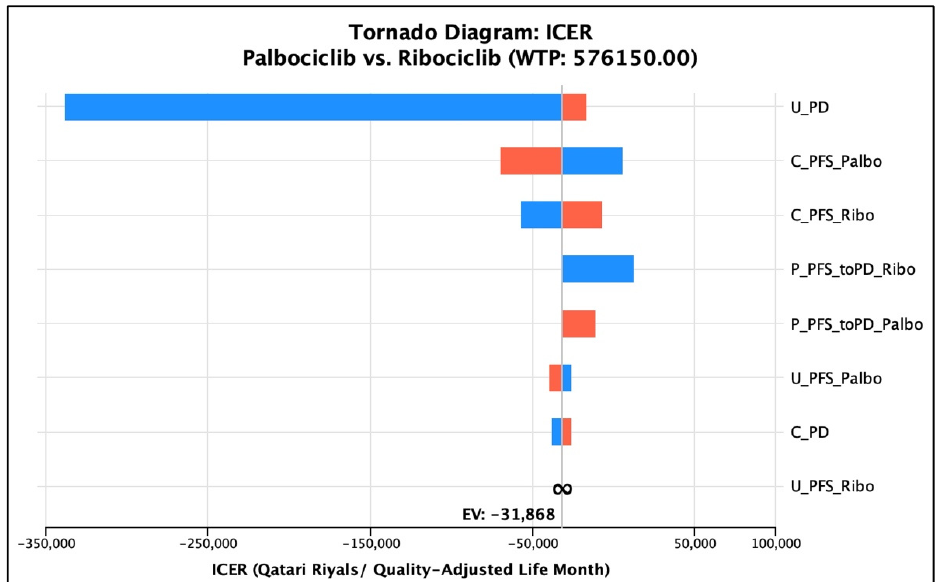
Figure 2. Tornado diagram of the univariate sensitivity analyses and their impact on ICER. The blue color represents the parameter, whereas the red color represents the ICER. U_PD: utility value of the ‘progressed disease’ health state; C_PFS_Palbo: cost of the ‘progression-free survival’ health state for the ‘palbociclib’ treatment group; C_PFS_Ribo: cost of the ‘progression-free survival’ health state for the ‘ribociclib’ treatment group; P_PFS_toPD_Ribo: transition probability from the ‘progression-free survival’ health state to the ‘progressed disease’ health state for the ‘ribociclib’ treatment group; P_PFS_toPD_Palbo: transition probability from the ‘progression-free survival’ health state to the ‘progressed disease’ health state for the ‘palbociclib’ treatment group; U_PFS_Palbo: utility value of the ‘progression-free survival’ health state for the ‘palbociclib’ treatment group; U_PFS_Ribo: utility value of the ‘progression-free survival’ health state for the ‘ribociclib’ treatment group; C_PD: cost of the ‘progressed disease’ health state. Table 5. DSA outputs for palbociclib and ribociclib groups at each of the uncertainty parameters with the overall cost-effectiveness conclusions .